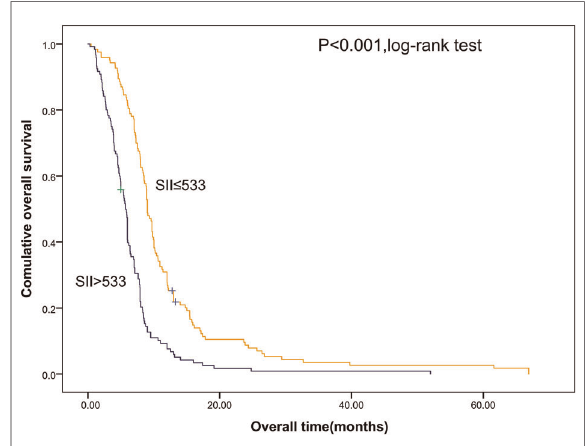
FIGURE 1 Kaplan – Meier graphs of OS for patients with high SII (>533) and low SII ( ≤ 533). OS, overall survival; SII, systemic immune-in fl ammation index.